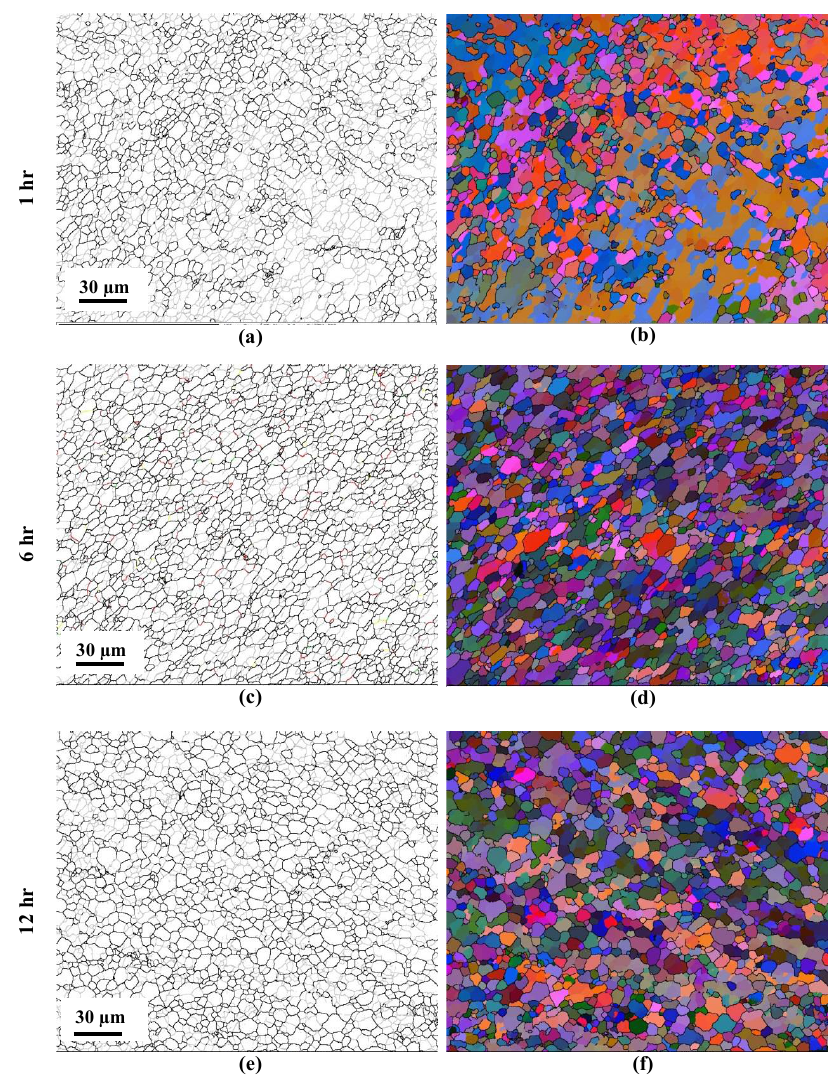
Figure 7. EBSD Grain boundary reconstruction maps and corresponding Euler maps of FSP AA6082 artificially aged at 200 °C for: ( a , b ) 1 h, ( c , d ) 6 h; ( e , f ) 12 h .